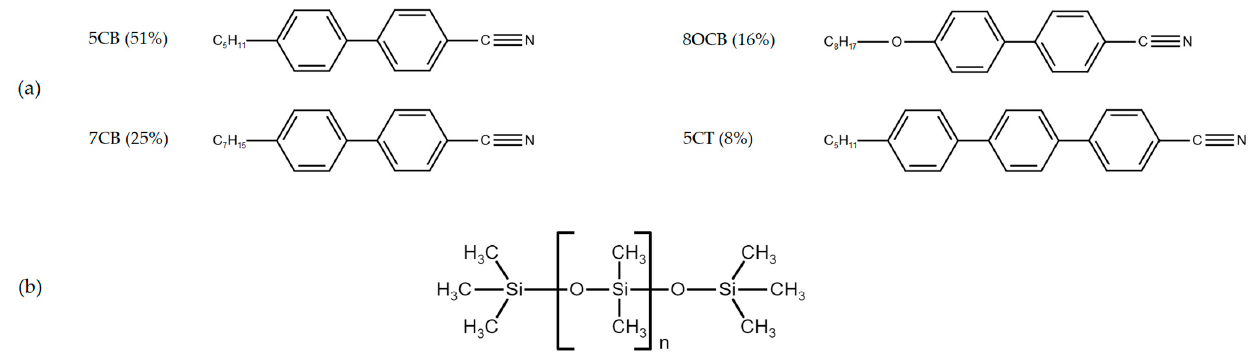
Figure 1. ( a ) Molecular structures and composition of E7 liquid crystal and ( b ) chemical structure of poly(dimethylsiloxane) (PDMS).